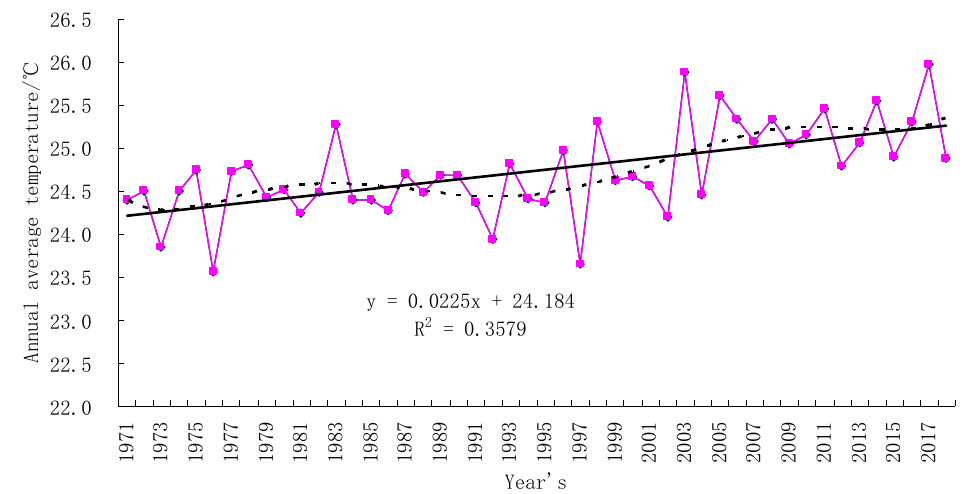
Figure 2. Trends of annual average temperature changes during the summer and autumn seasons in Fujian from 1971 to 2018.